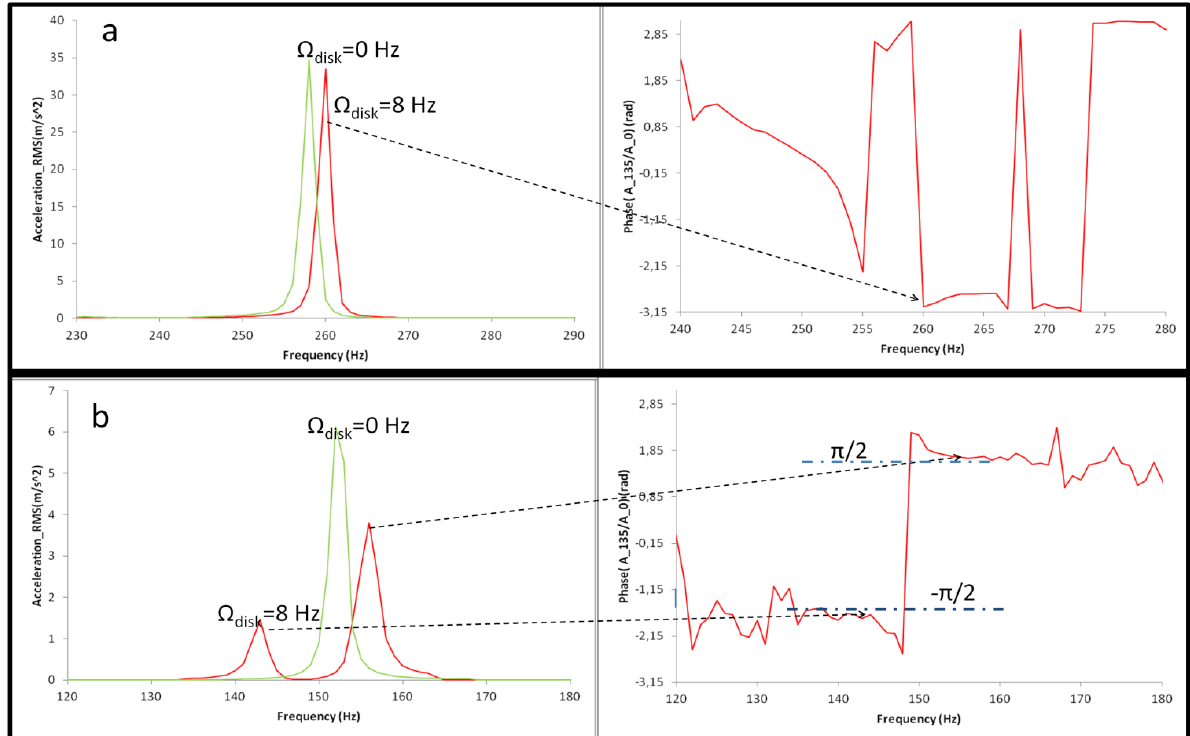
Figure 10. ( a ) Natural frequencies n = ±2 of the rotating disk in air at = 8 Hz; ( b ) Natural frequencies n = ±2 of the disk rotating in water at disk = 8 disk